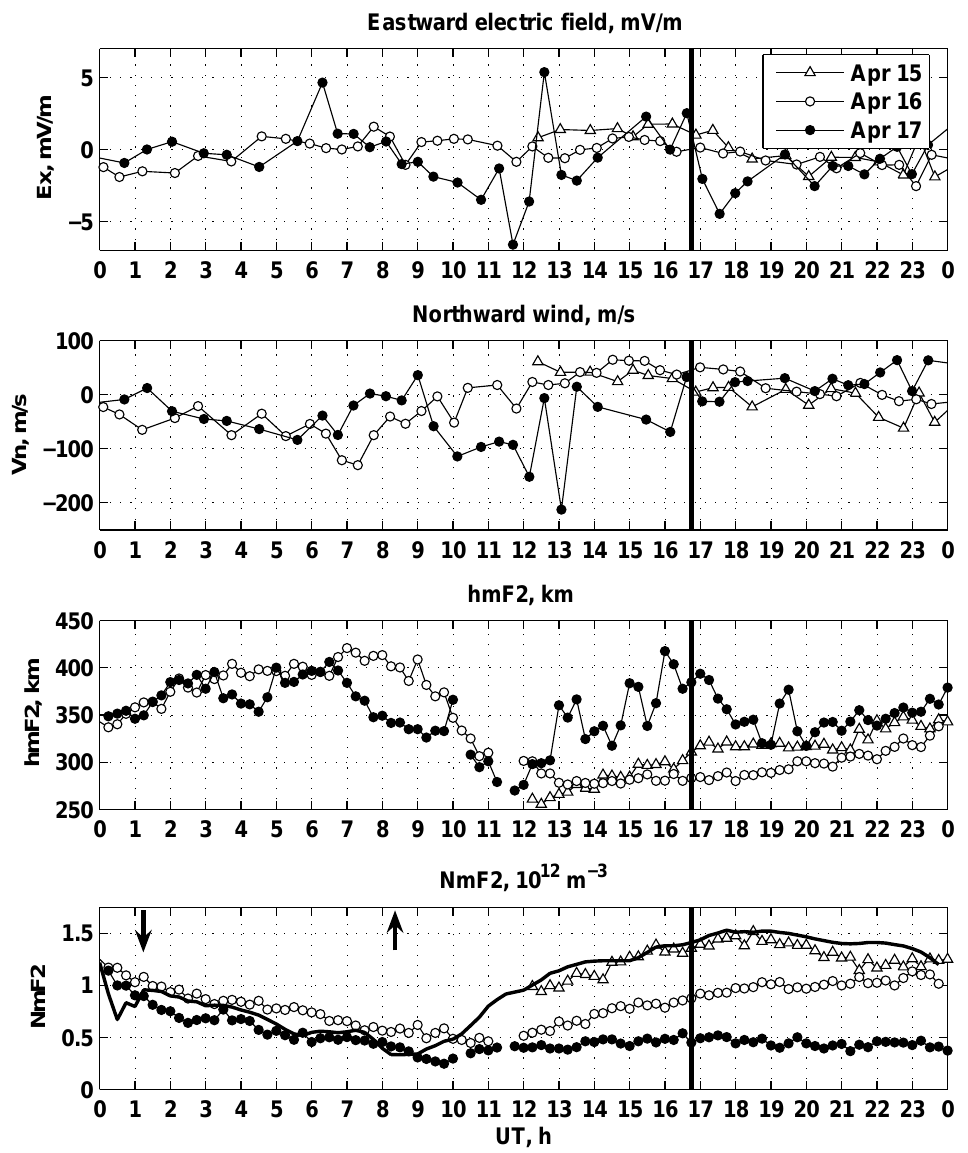
Fig. 15. Ionospheric and thermospheric parameters observed at Millstone Hill: eastward electric field, meridional wind (northward positive), height of the F-layer hm F2, and electron density at the peak of the F-layer Nm F2. Vertical lines indicate local noon, and arrows show sunrise and sunset times at 300km. Solid line in the bottom panel presents average quiet time Nm F2, obtained from the Millstone Hill digisonde for 1–15 April